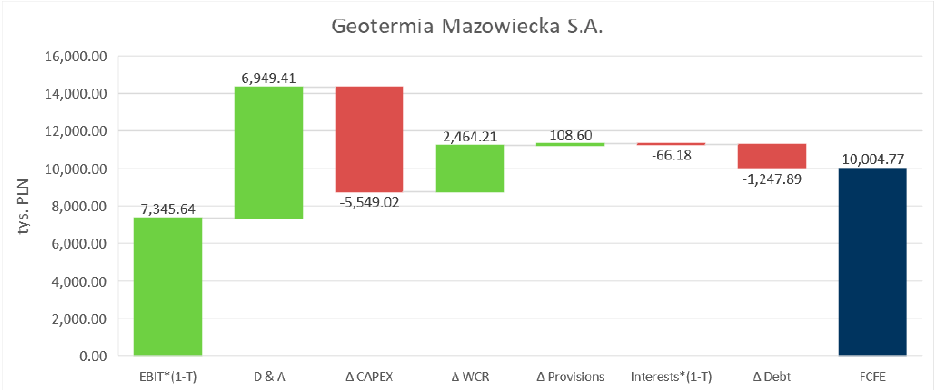
Figure 12. FCFF cash flows generated by Geotermia Mazowiecka S.A. in 2016–2019. Source: Own study on the basis of: [53].